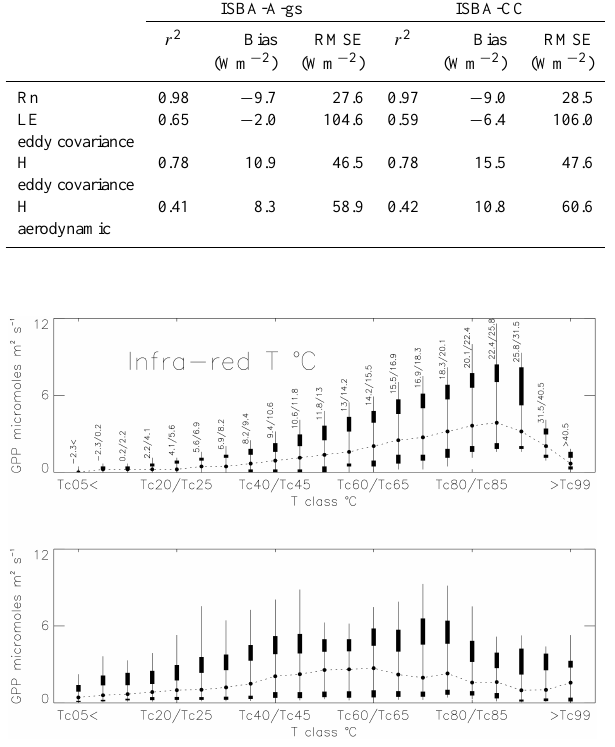
Fig. 4. Response of (top) the simulated GPP and of (bottom) the estimated GPP to the observed surface infrared-derived tempera- ture. The median difference (dots) is presented together with per- centile values. Line: 5–95% percentile, closed box (bottom) 10– 20% percentile, closed box (top) 80–90% percentile. GPP statistics are given for 21 temperature classes ( T c ) corresponding to 5% per- centile intervals.